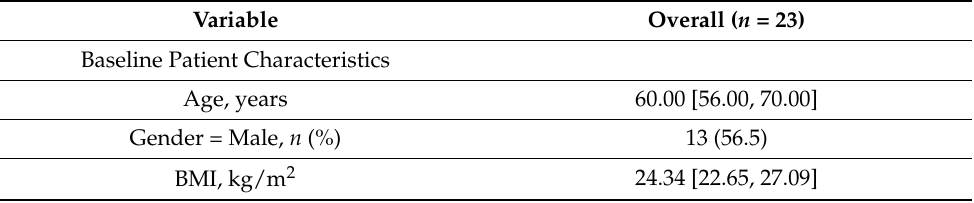
Table 1. Baseline clinical, laboratory, exercise and imaging characteristics of patients with AL